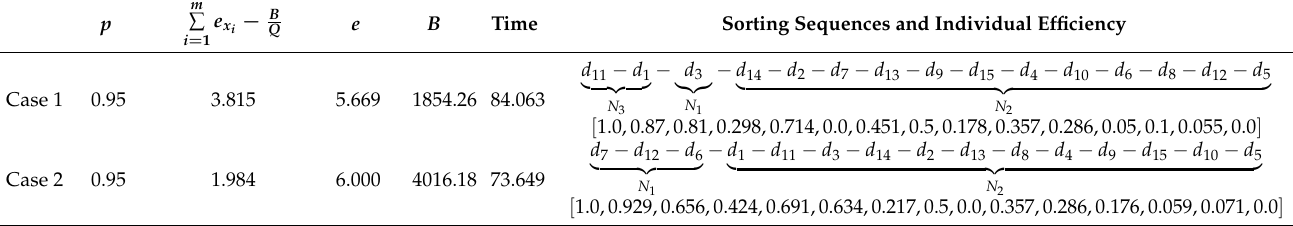
Table A9. Solutions of sorted negotiation Model (25) ( q = 0.95, T = 85). Sorting Sequences and Individual Efficiency